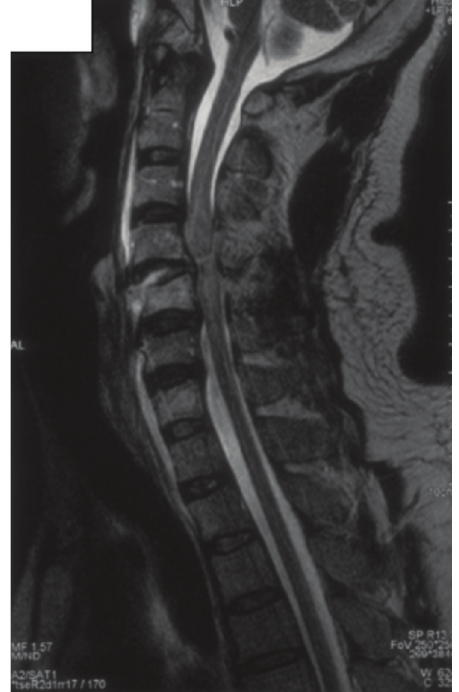
Complete transection of C5 level of spinal cord and cord Fig. 1: oedema (Day 1 MRI after admission).